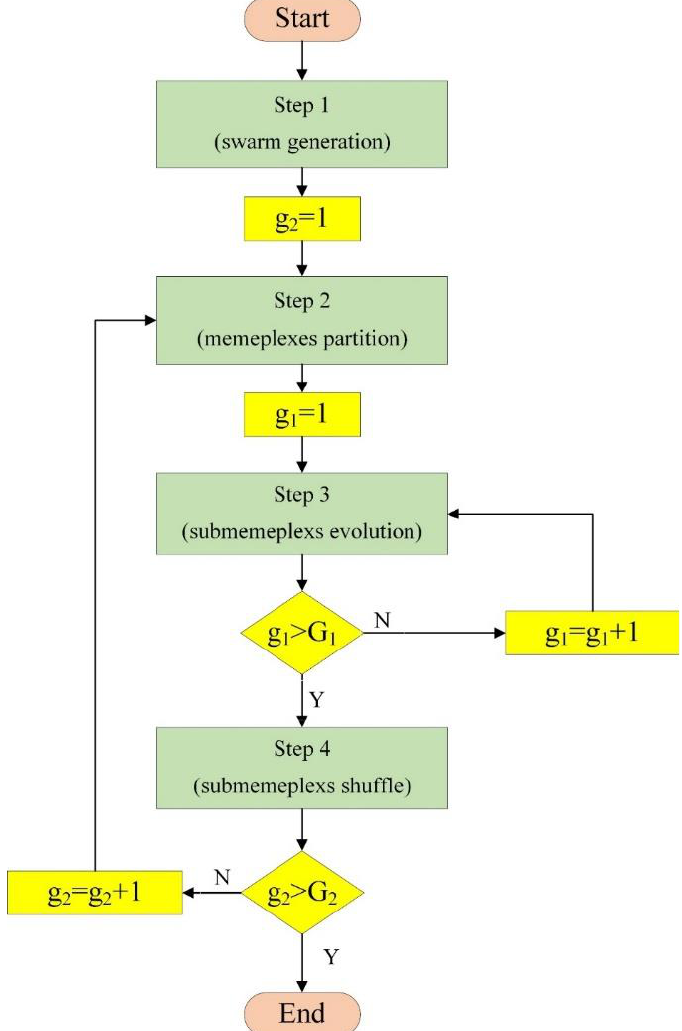
Figure 4. Flowchart of the shuffled frog-leaping algorithm.